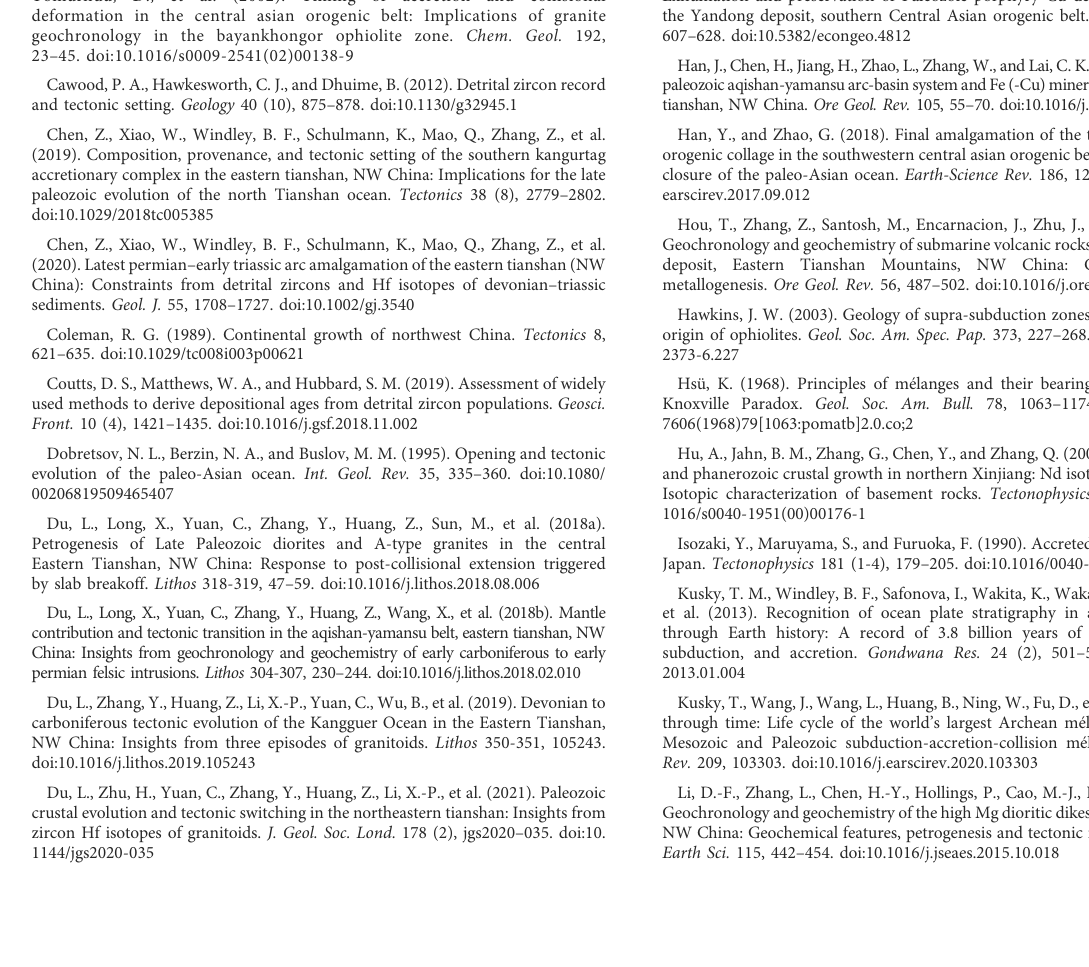
SUPPLEMENTARY TABLE S4 Zircon U ‒ Pb ages of the sedimentary rocks around the KGSC in the eastern